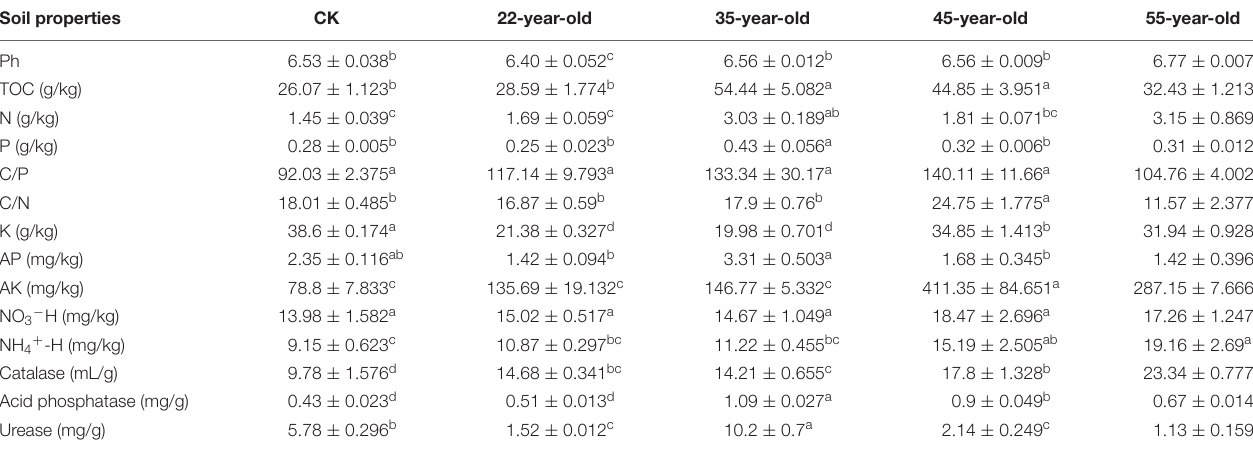
TABLE 2 | Soil properties in the rhizosphere of 22, 35, 45, and 55-year-old teak plantations in an adjacent grassland (CK) in Mt. Jianfengling, Hainan island, China. Soil